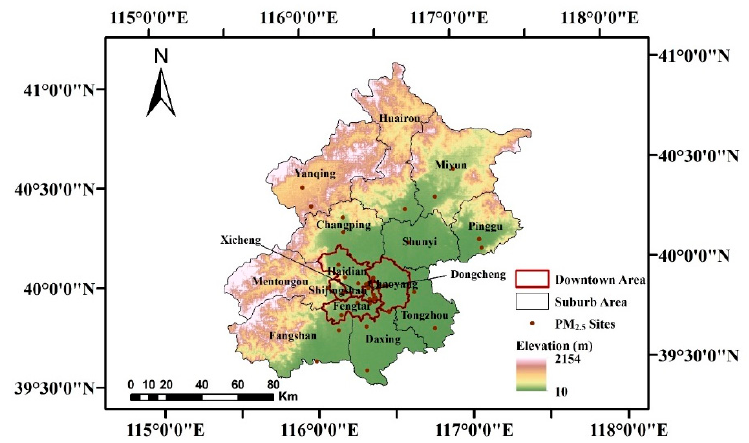
Figure 1. Topography of Beijing and the spatial distribution of PM 2.5 sites.